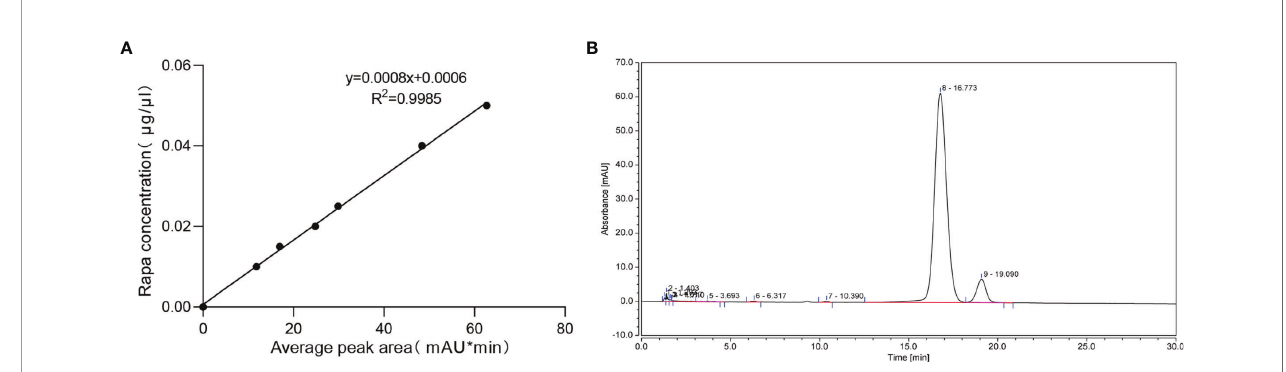
FIGURE 3 | (A) The linear regression equation of rapamycin standard curve. (B) The chromatographic peak of rapamycin in Rapa-sEVs detected by HPLC.